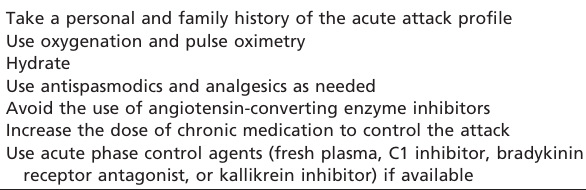
Table 4 - General recommendations for the medical treatment of attacks of hereditary